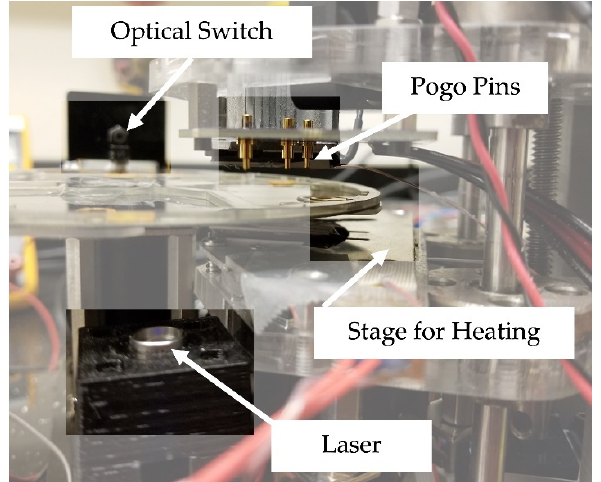
Figure 2. The automated system for microchip electrophoresis has a laser for opening valves, a stage that sits along the separation channel for heating, an optical switch for alignment, and pogo pins to apply voltages to electrodes on the disc during electrophoresis.